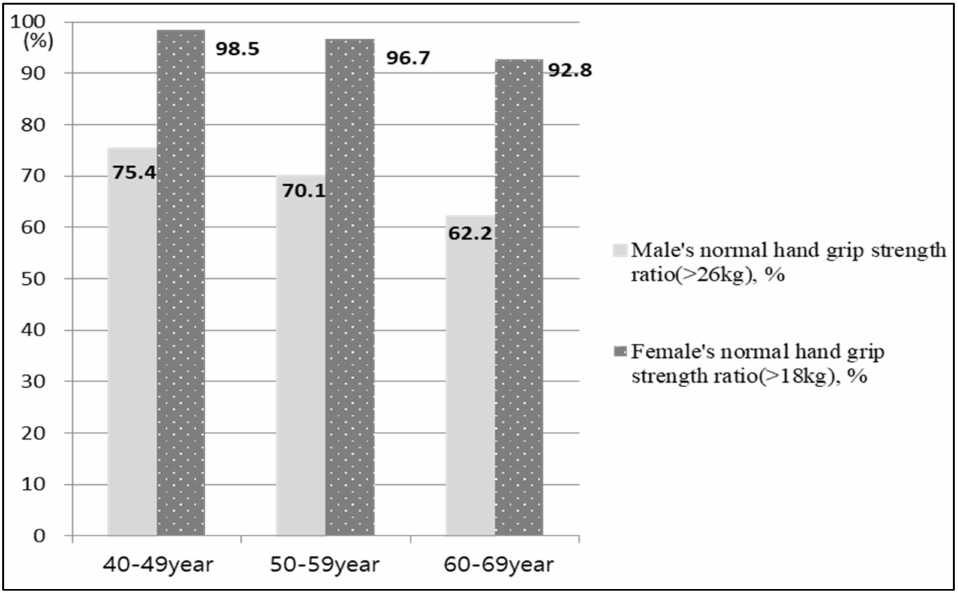
Figure 2. Di ff erences in male and female normal grip strength ratio according to